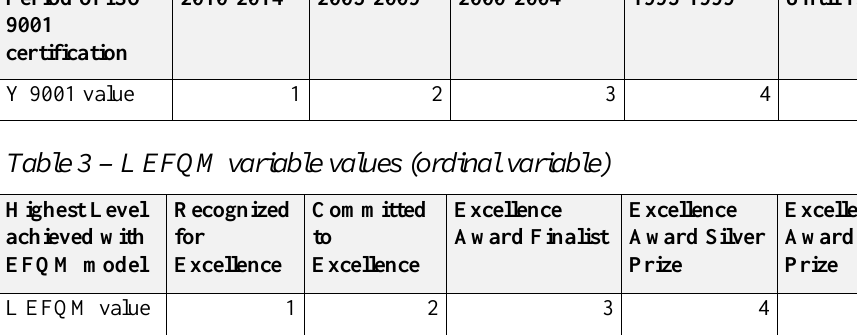
Table 2 – Y ISO 9001 variable values (quantitative discrete variable) Period of ISO